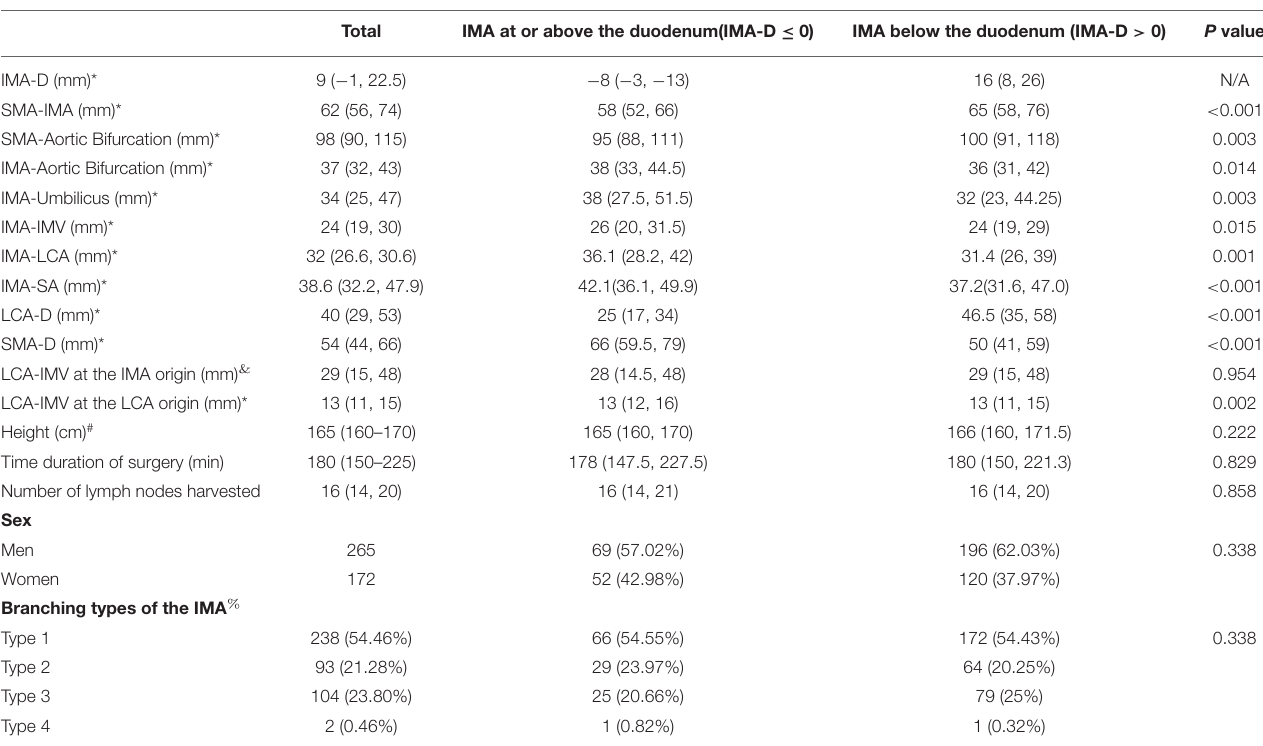
TABLE 2 | Patients with the IMA locating at or above the duodenum vs. below the duodenum. Total IMA at or above the duodenum(IMA-D ≤ 0) IMA below the duodenum (IMA-D >